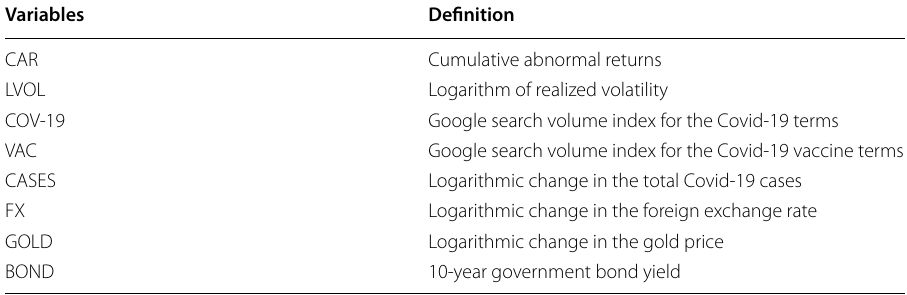
Table 1 Description of variables